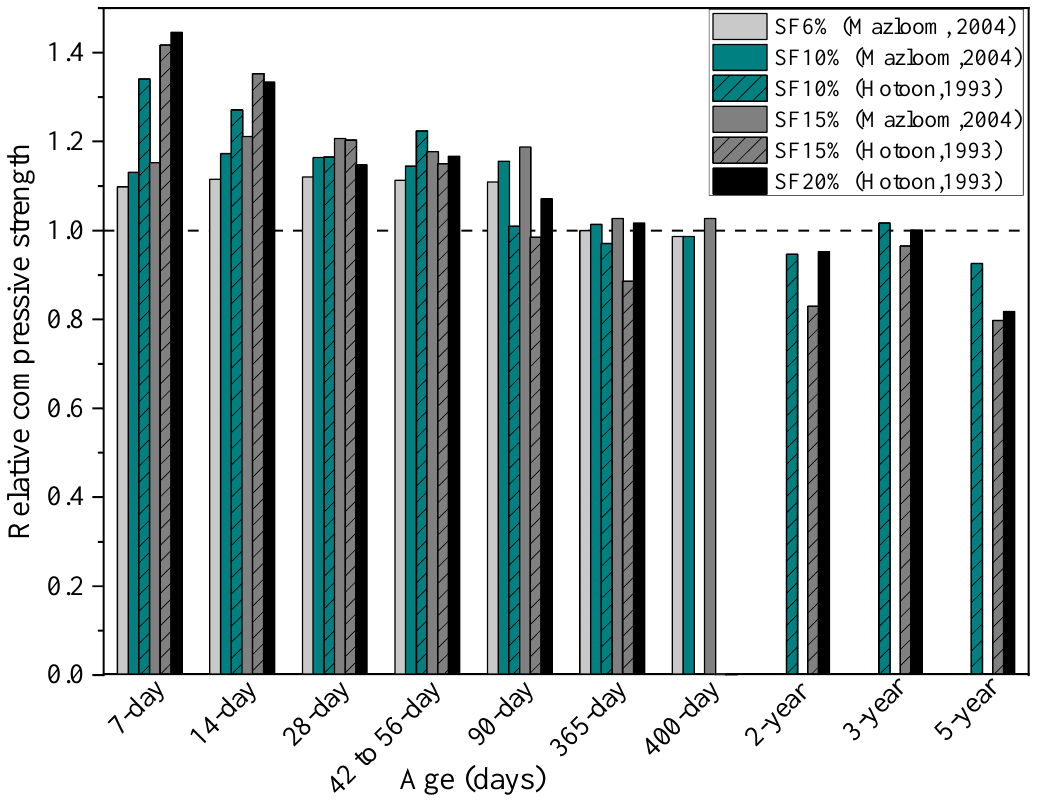
Figure 2. Relative compressive strength of concrete containing silica fume (SF) at various curing curing ages ages [18,21].